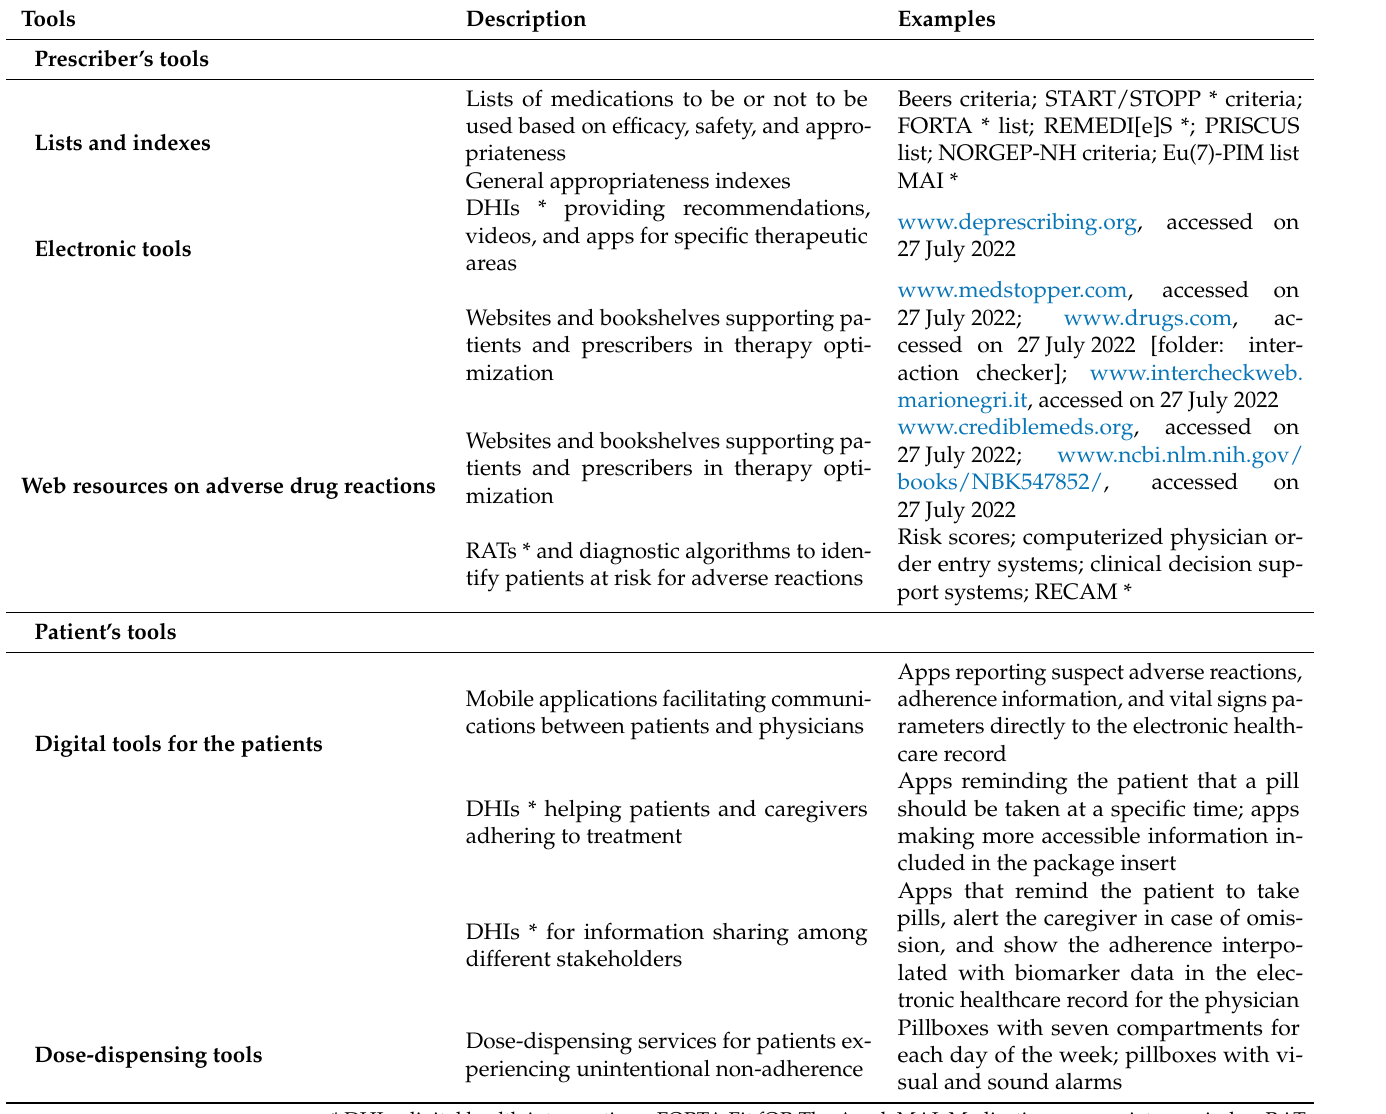
Table 1. Main tools supporting the appropriate drug